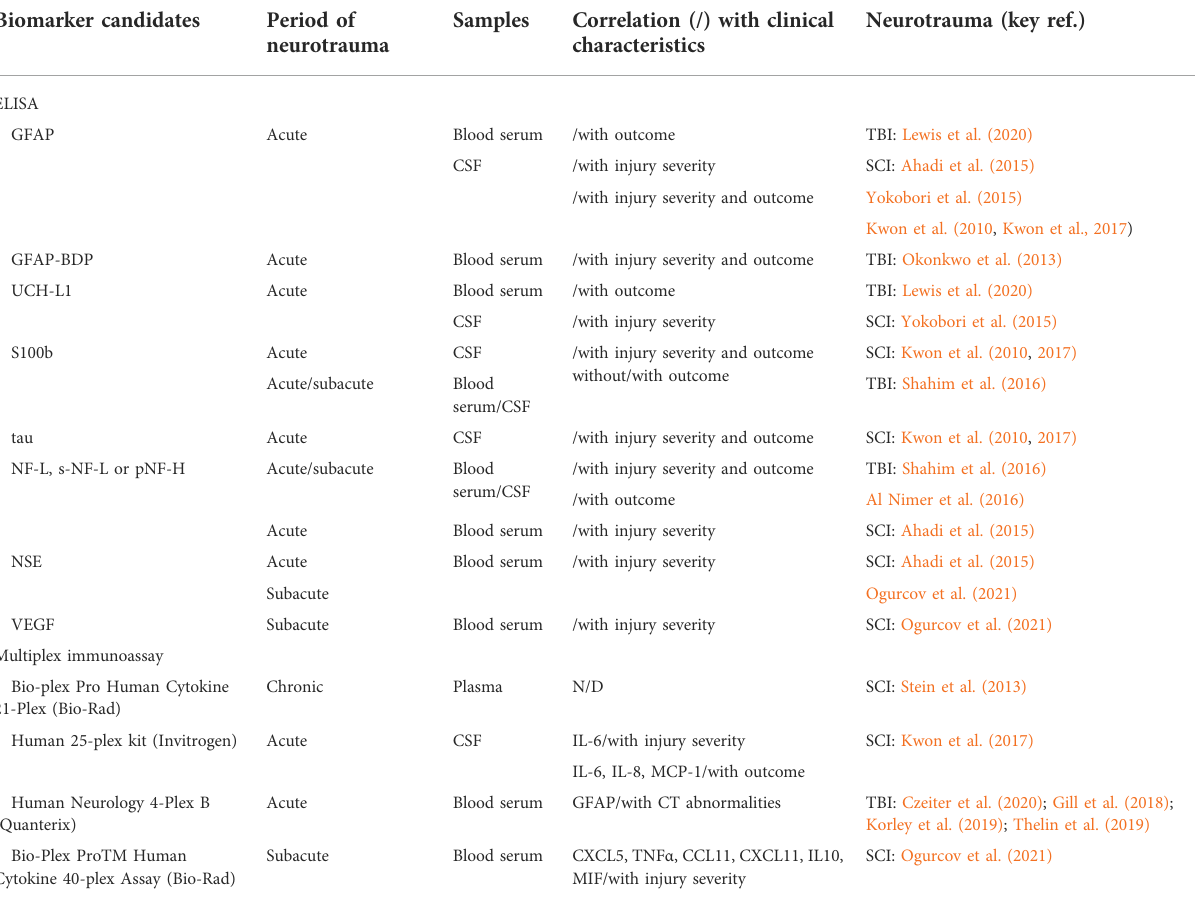
TABLE 1 Candidate biomarkers that are detected by immunoanalysis in neurotrauma. Biomarker